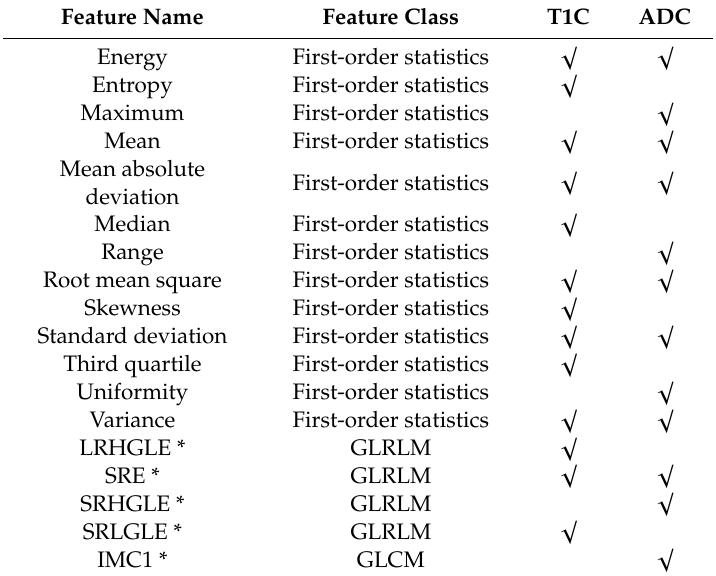
Table 3. Summary of distinct radiomic features for models derived from T1C and